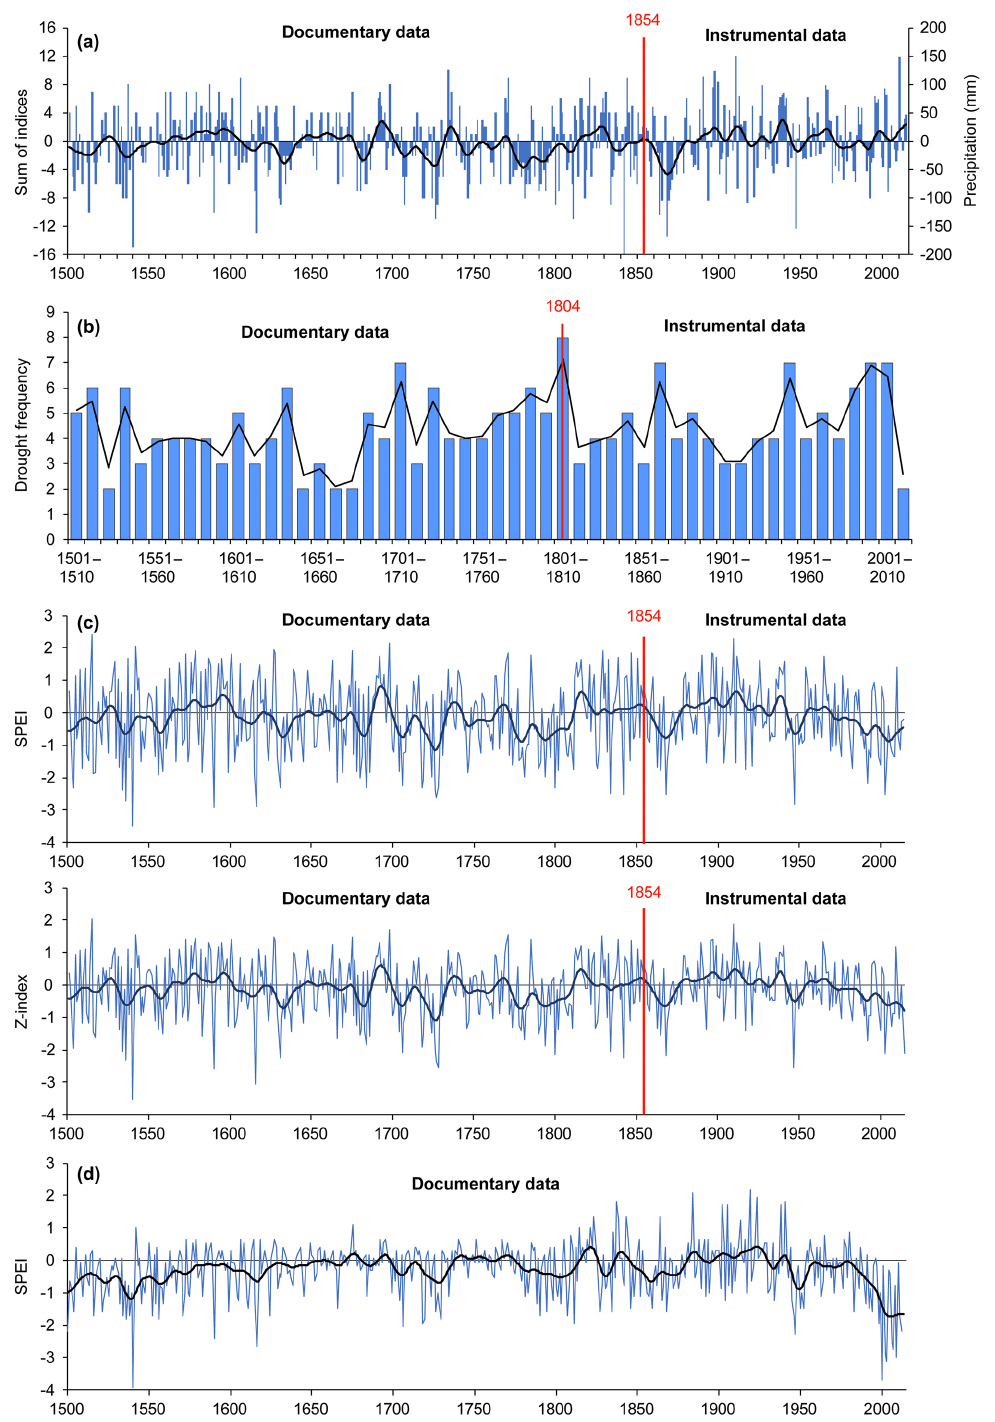
Figure 5. Various types of long-term drought reconstructions for the Czech Lands: (a) April–September sums of precipitation indices from documentary data for 1501–1854 and precipitation totals for 1855–2014; (b) decadal frequencies of drought episodes for 1501–2012 (Brázdil et al., 2013); (c) April–September SPEI and Z -index for 1501–2014 derived from documentary data (Brázdil et al., 2016a); (d) April–August SPEI for 1499–2012 from grape harvest dates (Možný et al., 2016b). Smoothed by Gaussian filter over 20 years (black curves).